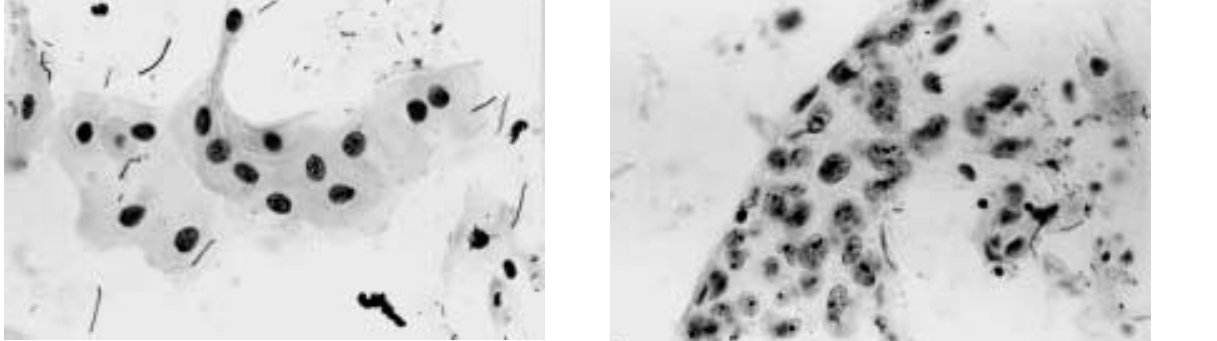
Fig. 2. Squamous carcinoma cells revealing multiple NORs as clus- ters (within nucleoli) and as satellites (outside nucleoli). 100 × ob-